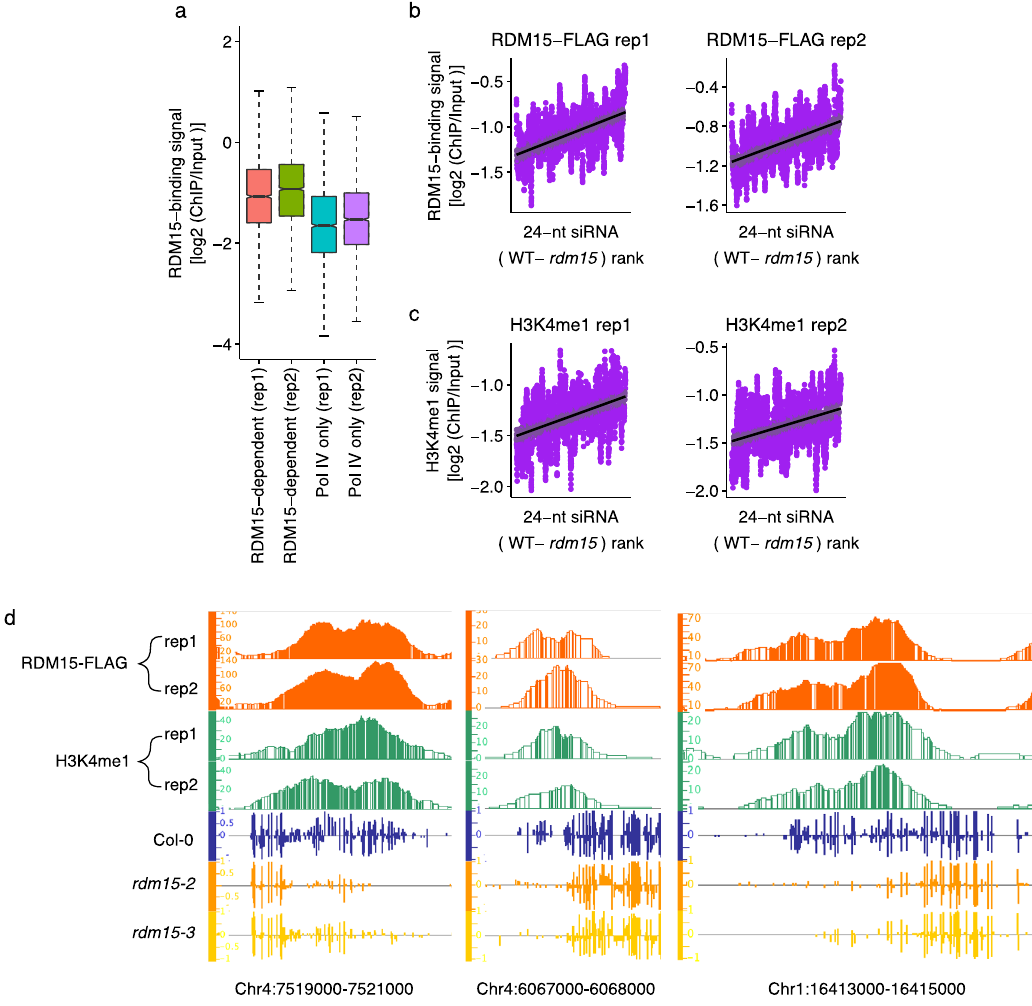
Fig. 7 RDM15 binds to RDM15-dependent siRNA regions in the genome. a Boxplots showing RDM15 protein enrichment in RDM15-dependent siRNA regions. PoI IV-only siRNA regions, which were not affected in rdm15 , served as the control. In the boxplots, the center is the median of the data; upper bound of the box is an upper hinge, 75% quantile of the data; lower bound of the box is a lower hinge, 25% quantile of the data; minima is the smallest data point greater than or equal to lower hinge − 1.5 x interquartile range (IQR); maxima is the largest data point less than or equal to upper hinge + 1.5 x IQR. b Correlation of the change of siRNA accumulation (WT vs. rdm15 ) with RDM15 enrichment. RDM15-dependent siRNA regions were ranked by the change of siRNAs (WT vs. rdm15 ). c Correlation of the change of siRNA accumulation (WT vs. rdm15 ) with H3K4me1 enrichment. RDM15-dependent siRNA regions were ranked by the change of siRNAs (WT vs. rdm15 ). d IGB display of RDM15 and H3K4me1 protein enrichment and DNA methylation levels at several RDM15 binding